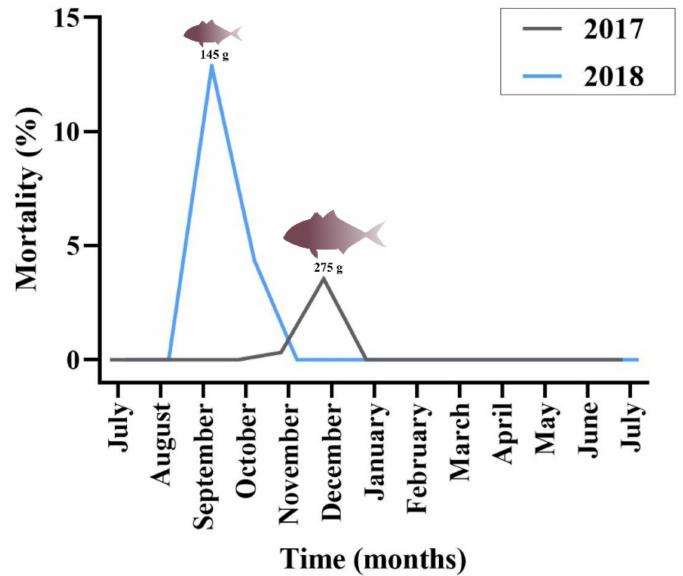
Figure 2. Mortality attributed to epitheliocystis in greater amberjack cohorts in 2017 and 2018. Fish weight during the outbreak is noted on the